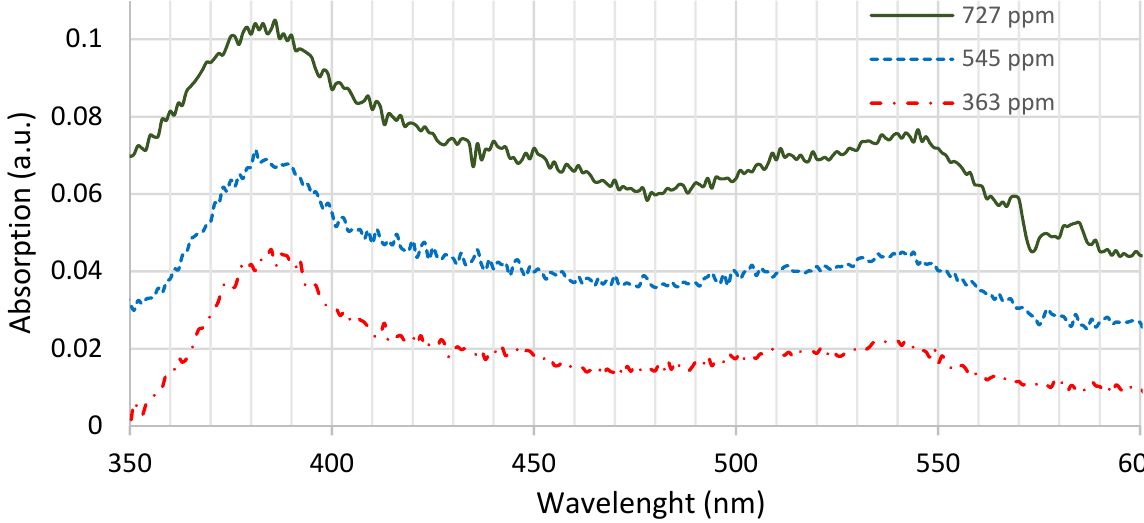
Figure 7. Typical absorption of PtOEP for different concentrations with similar thicknesses, namely 0.2 mm for the membranes of 363 ppm and 545 ppm of concentration and 0.15 mm for the membrane of 727 ppm of concentration.